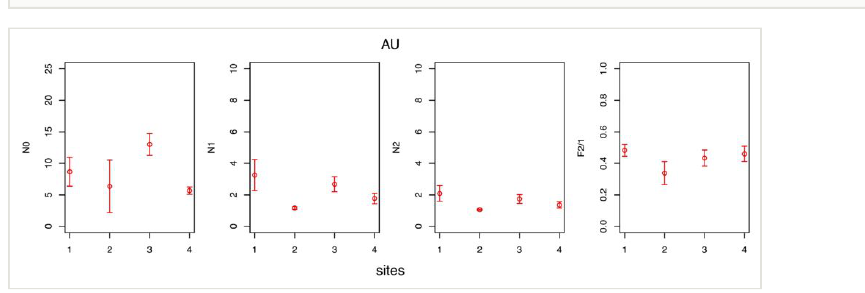
Figure 9. Variability of the observed species diversity and eveness along the sites (1, 2, 3, 4) transect during the autumn (AU) survey. Diversity was measured using the Hill numbers N0, N1 and N2, whereas eveness was measured with the F2/1